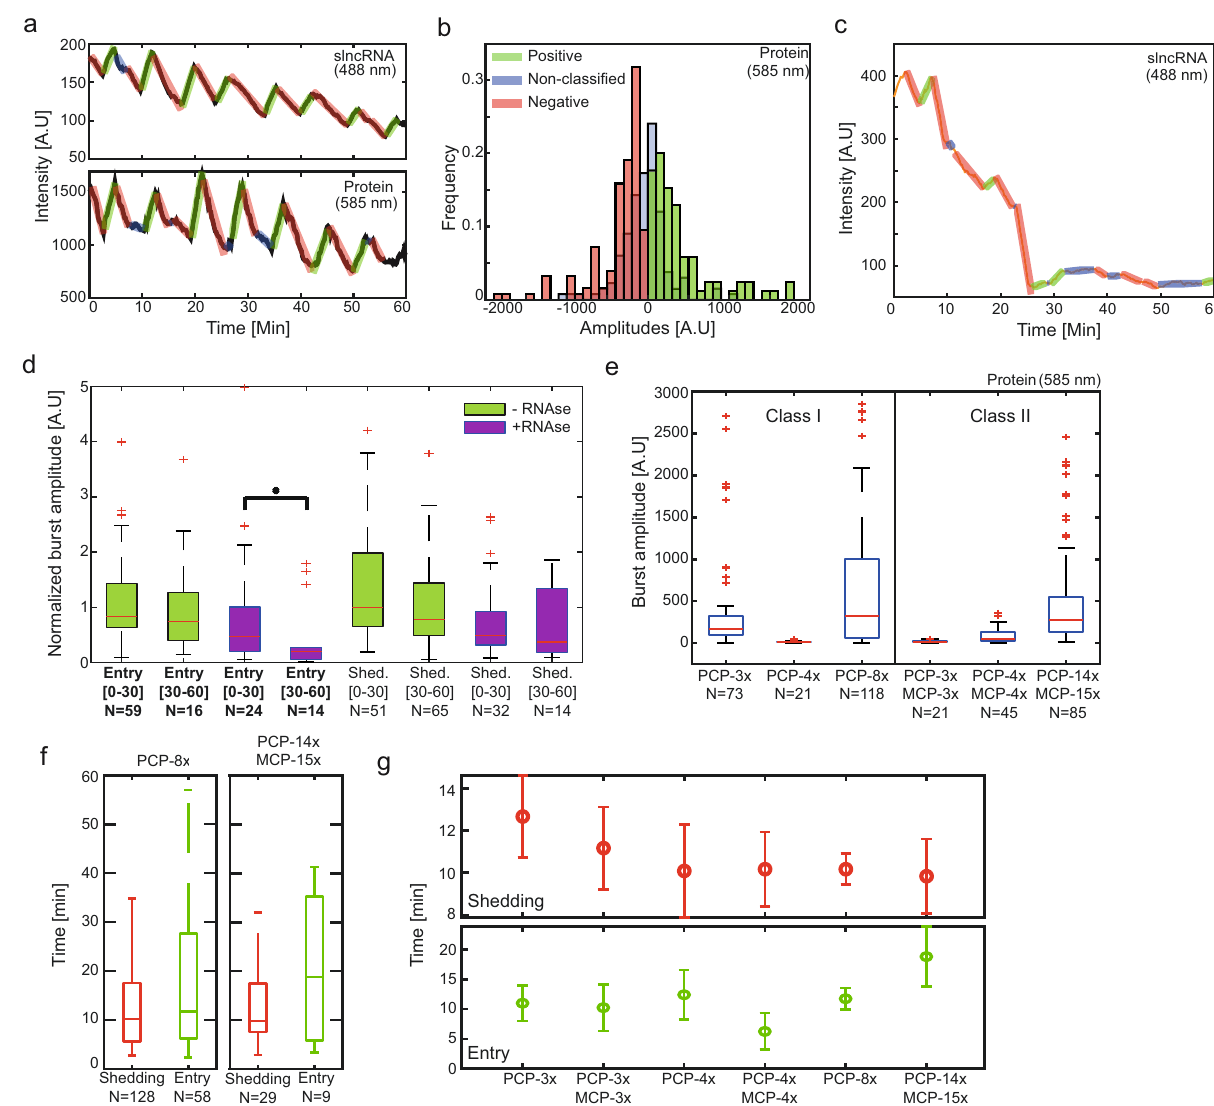
f Sampleboxplotsdepictingdistributionsofdurationsbetweenapositiveburstand a subsequent positive burst (green), and durations between a negative burst and